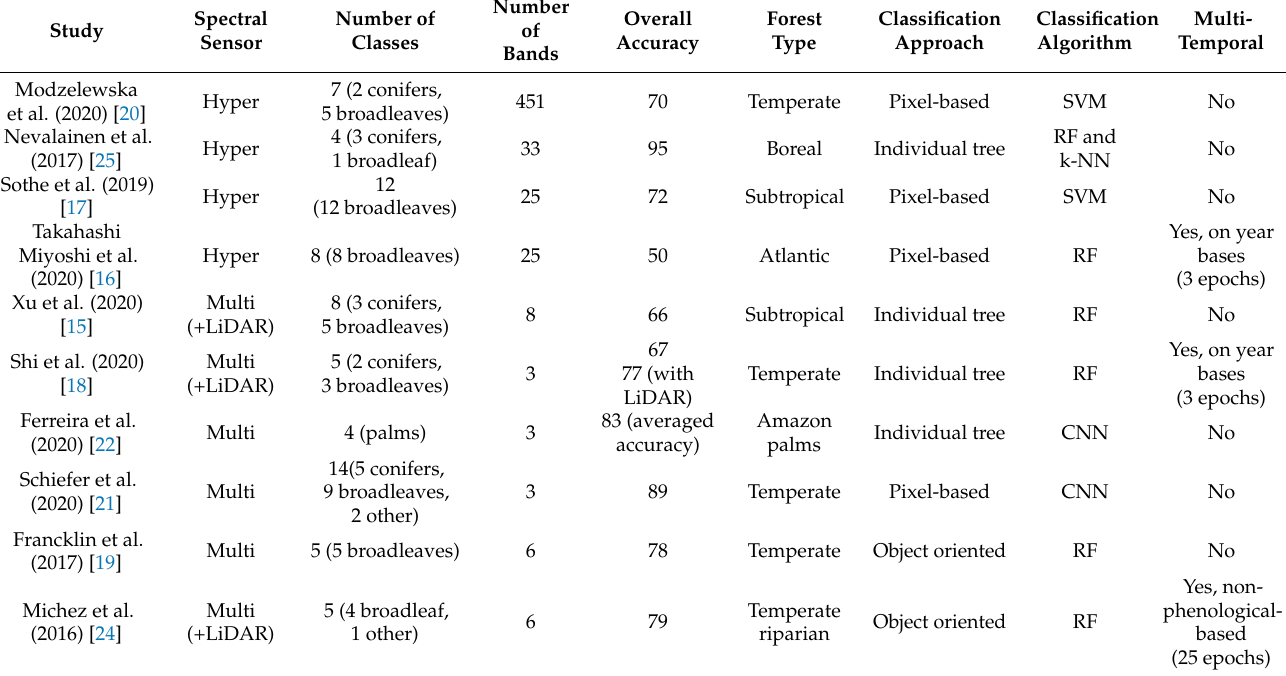
The number of classes, their nature, the sensor, the classification algorithm, the overall accuracy of the type of classified environment, the classification approach and the multi-temporality of the input dataset are described. When different methods were compared in the study, the best results are reported. SVM = support vector machine; RF = random forest; k-NN = k-neural networks; CNN = convolutional neural